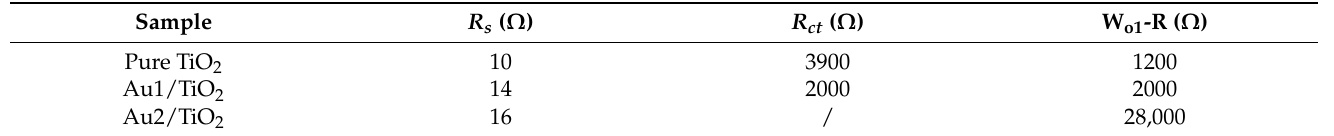
Table 2. The values of solution resistance ( R s ) and electron transfer resistance ( R ct ) for the tested